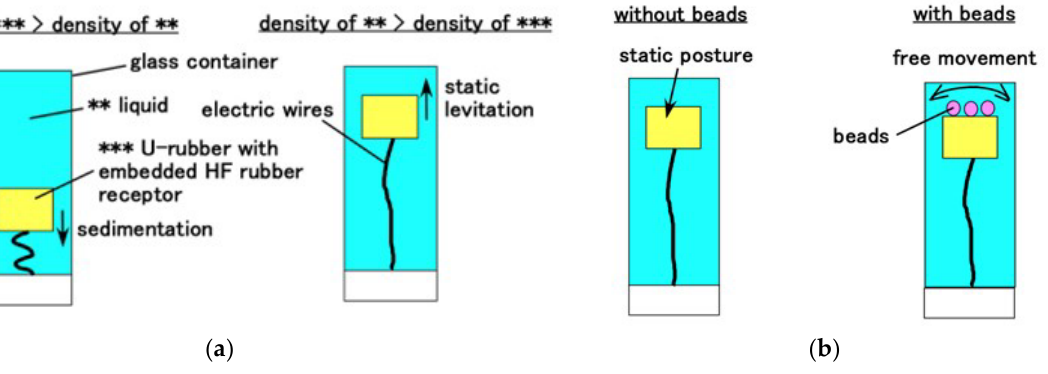
Figure 6. Posture of the hair cell in the equilibrium sensor mimicking a saccule: ( a ) relation between the levitation and density of the liquid and ( b ) effect of beads mimicking otoliths on the posture. For the hair cell, such as cochlea, which is used for sound wave sensing, the fabricated HF rubber hair cell is enclosed in a container, as shown in Figure 4d,e in the case of free